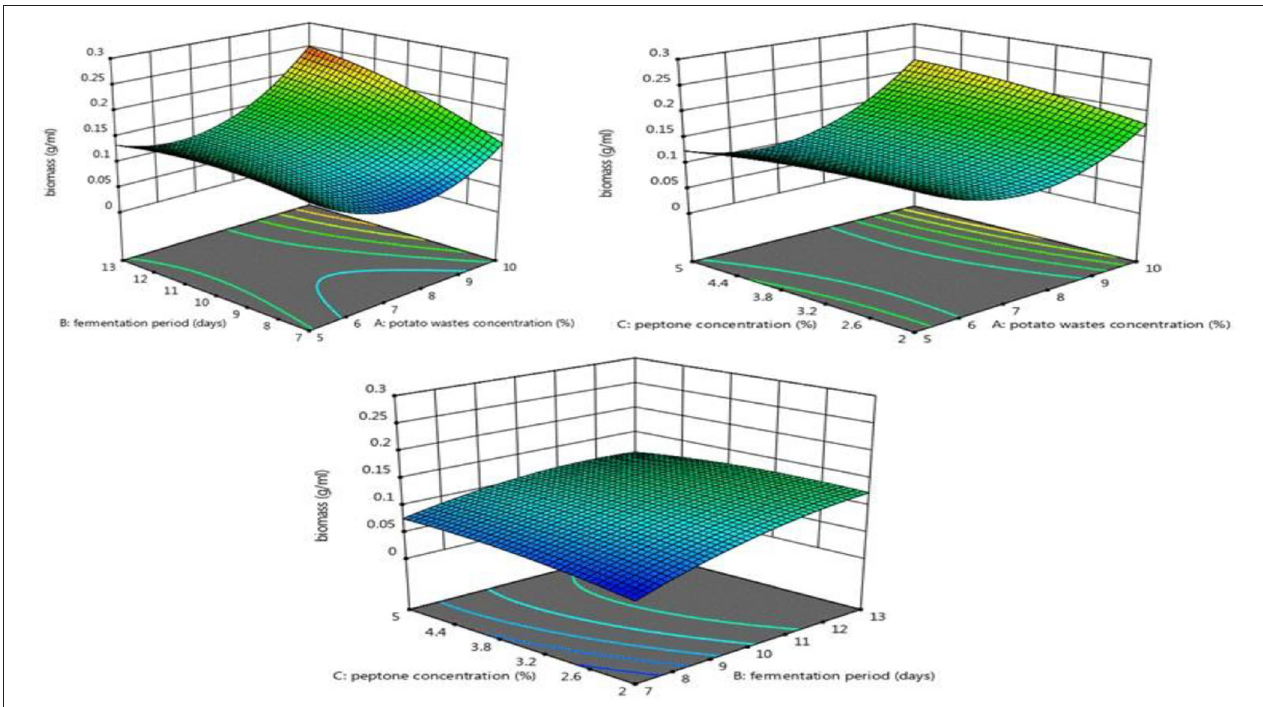
TABLE 7 | Mean sensory scores of ice lolly samples colored with Monascus purpureus NRRL 1992 pigments. Items and score Taste